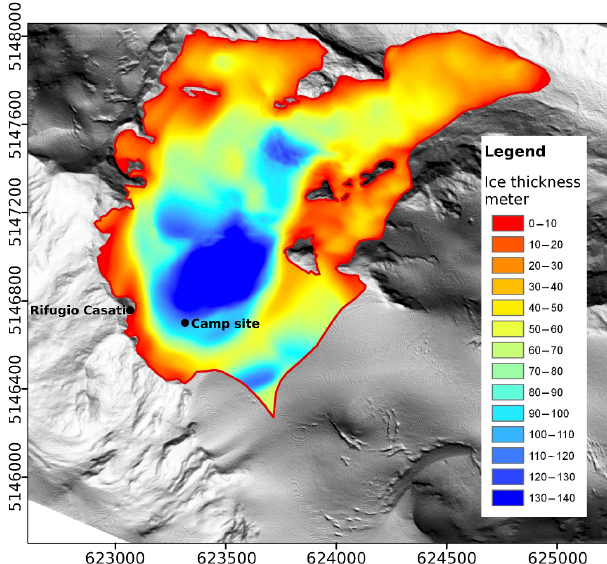
Figure 1. Map of the Langenferner glacier and its thickness based on a modified figure in Stocker-Waldhuber (2010). The Casati hut and camp site of the field test are indicated. Coordinates are in UTM coordinates with east on the x axis and north on the y axis.